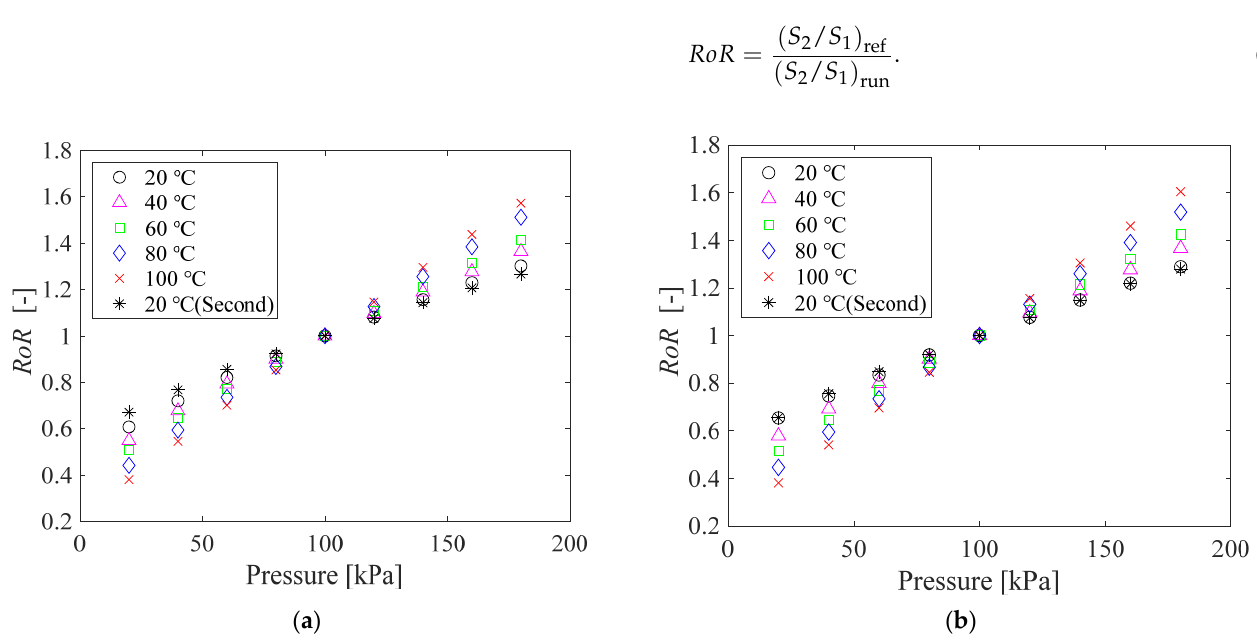
Figure 5. The relationship between the pressure and the RoR of PC-PSP ( a ) before and ( b ) after the heat treatment.